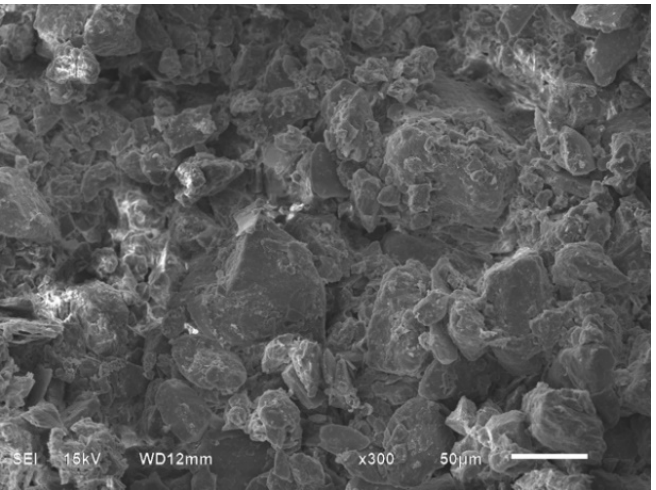
Figure 6. Microscopic image of loess.